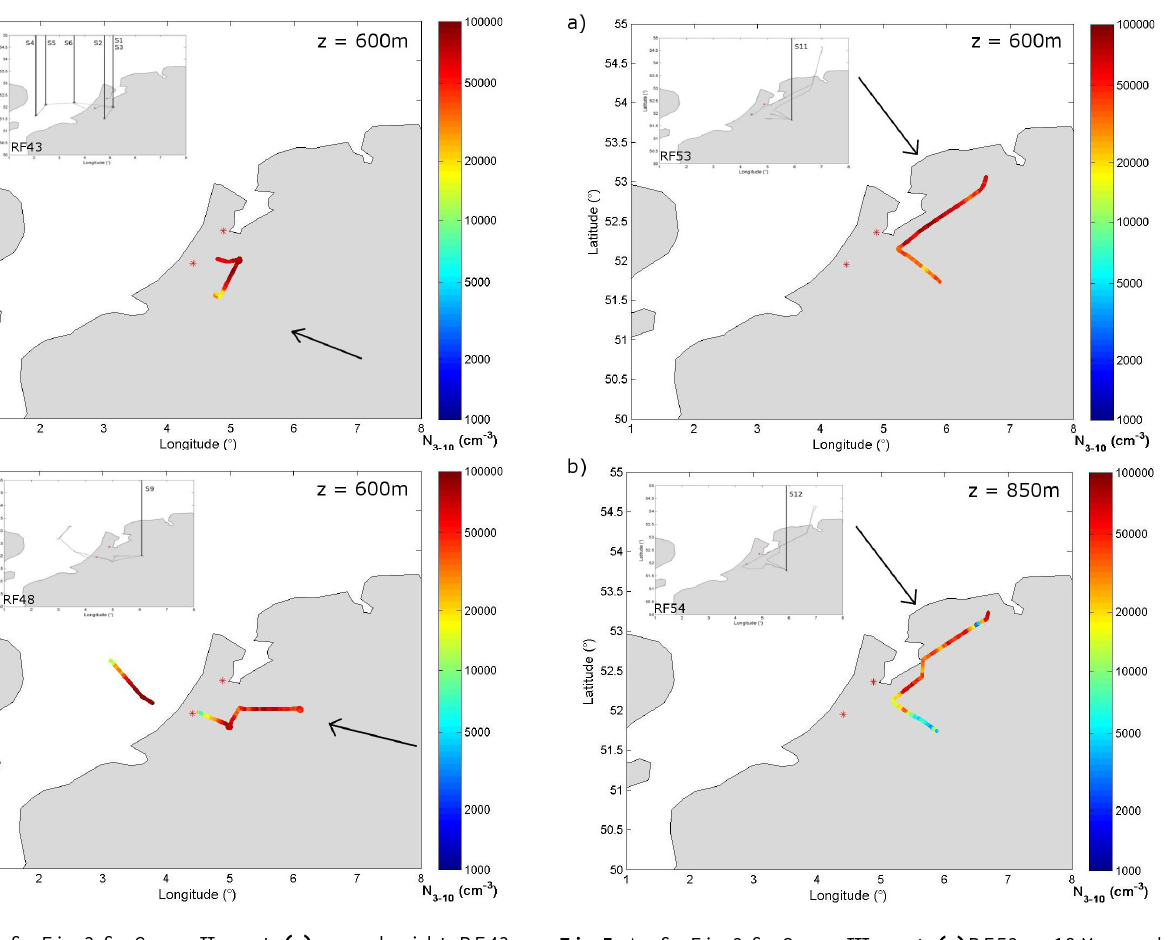
Fig. 5. As for Fig. 3 for Group III events (a) RF53 on 18 May and (b) RF54 on 18